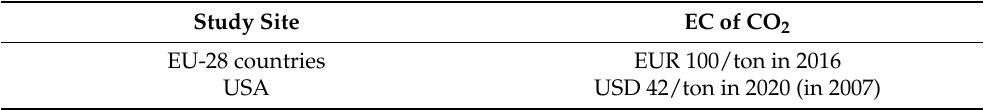
Table 7. Social environmental cost estimates of CO 2 emissions from ships. Study Site EC of CO 2 EU-28 countries EUR 100/ton in 2016 USA USD 42/ton in 2020 (in